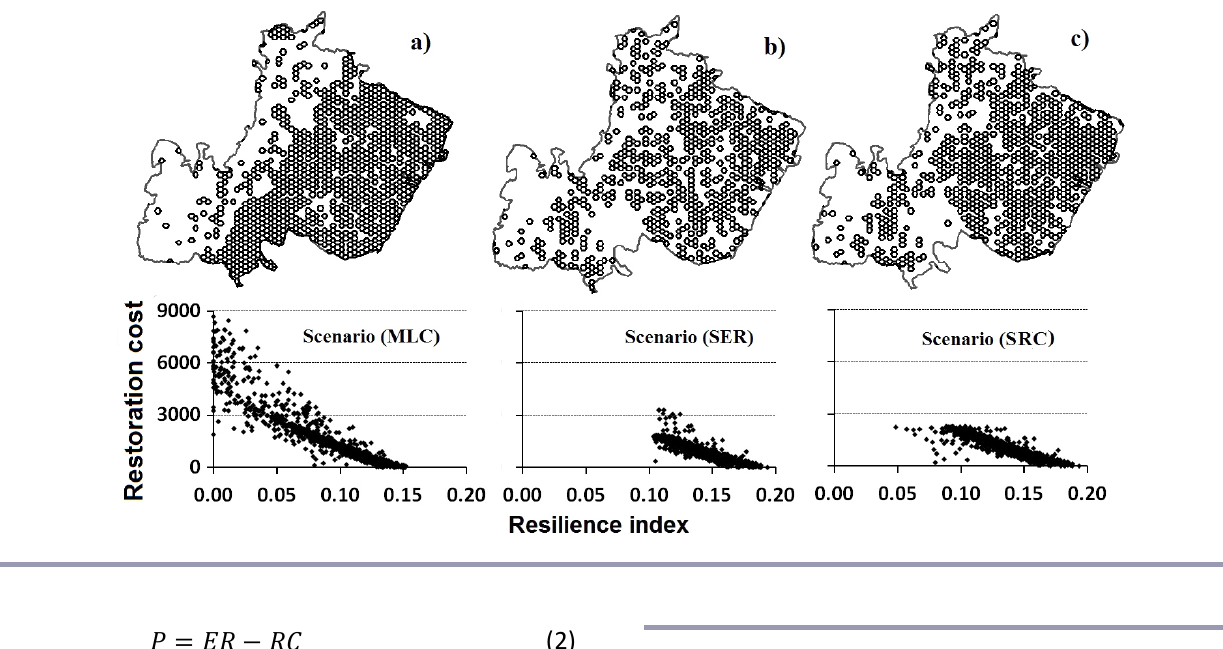
Fig. 4 . Selected planning unit (PU) for different targets for ecological restoration in the Cerrado biome of the Mato Grosso do Sul state, and respective relationships between landscape resilience and restoration cost. (a) Minimal legal compliance scenario (MLC), (b) selection by ecological resilience scenario (SER), and (c) selection by restoration cost scenario (SRC).